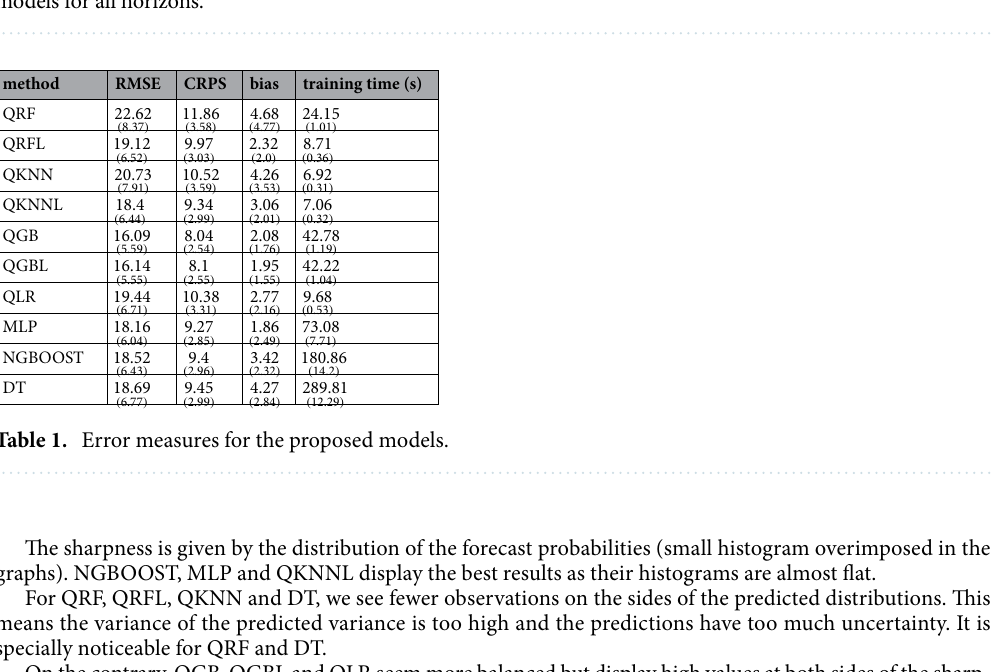
Figure 3. Boxplot of continuous ranked probability score, root mean squared error and bias of the different models for all horizons.